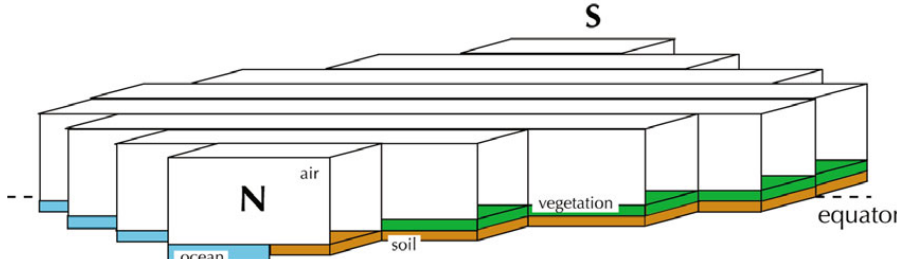
Fig. 3. Global multimedia model CliMoChem. Reprinted with permission from Scheringer et al. [13]. Copyright 2000 American Chemical Society.